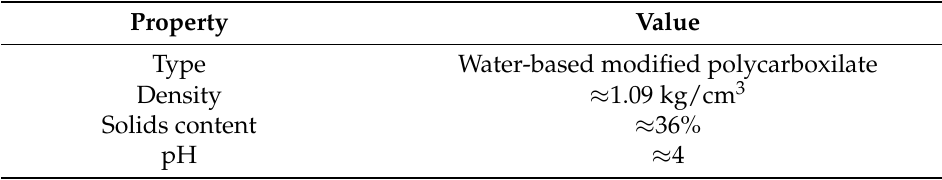
Table 4. Superplasticiser